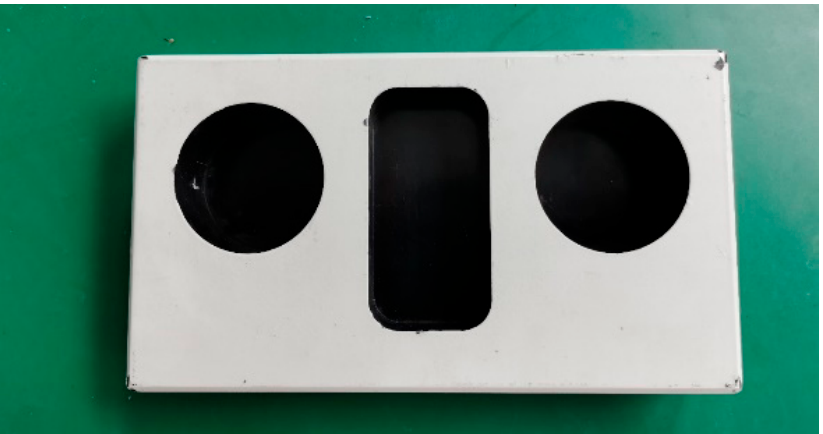
Figure 7. Test piece.